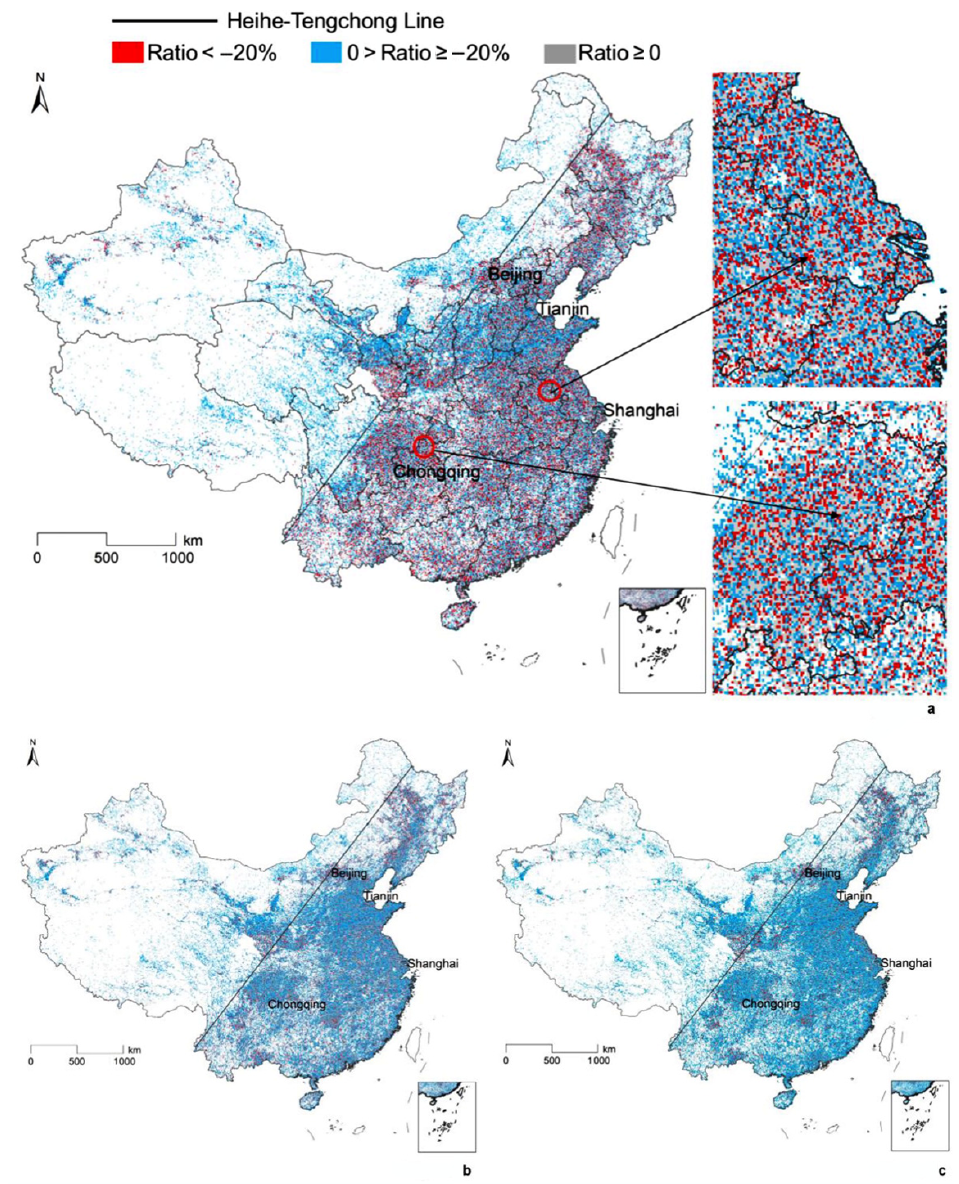
Figure 4. Human activity-intensity change rate in the three periods: ( a ) Change ratio in the first period, ( b ) Change ratio in the second period, ( c ) Change ratio in the third period.